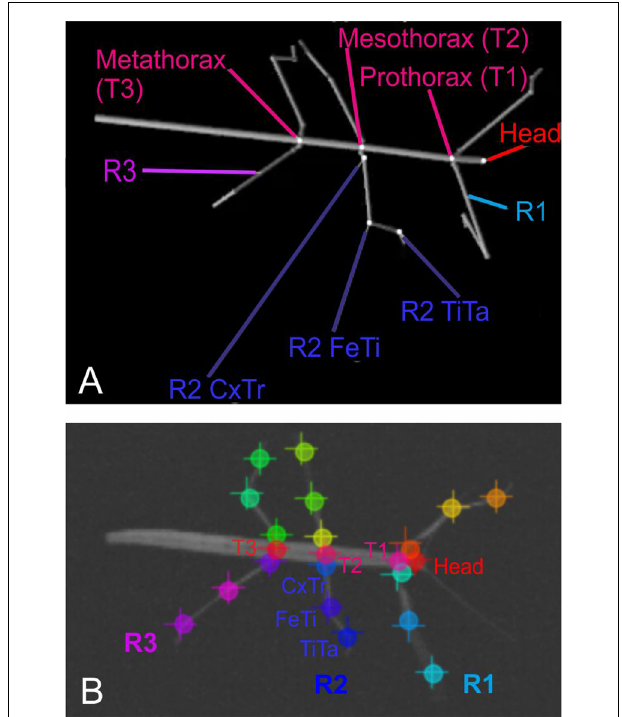
FIGURE 1 | Body geometry of the stick insect and tracked body features. (A) Single rendered posture as used for training, with labels indicating the body features that were to be tracked. The right front, middle and hind legs are labeled R1 to R3. The three features per leg to betracked are shown for the middle leg R2: these are the coxa-trochanter joint (R2 CxTr), the femur-tibia joint (R2 FeTi), and the tibia-tarsus joint (R2 TiTa). (B) Example frame of an experimental video with labels at the tracked body features. The + symbols mark manually annotated positions; circles mark network estimates. Note that trained networks can deal with motion blur. Despite motion blur of the right front leg and left middle leg, leg postures may be estimated well.